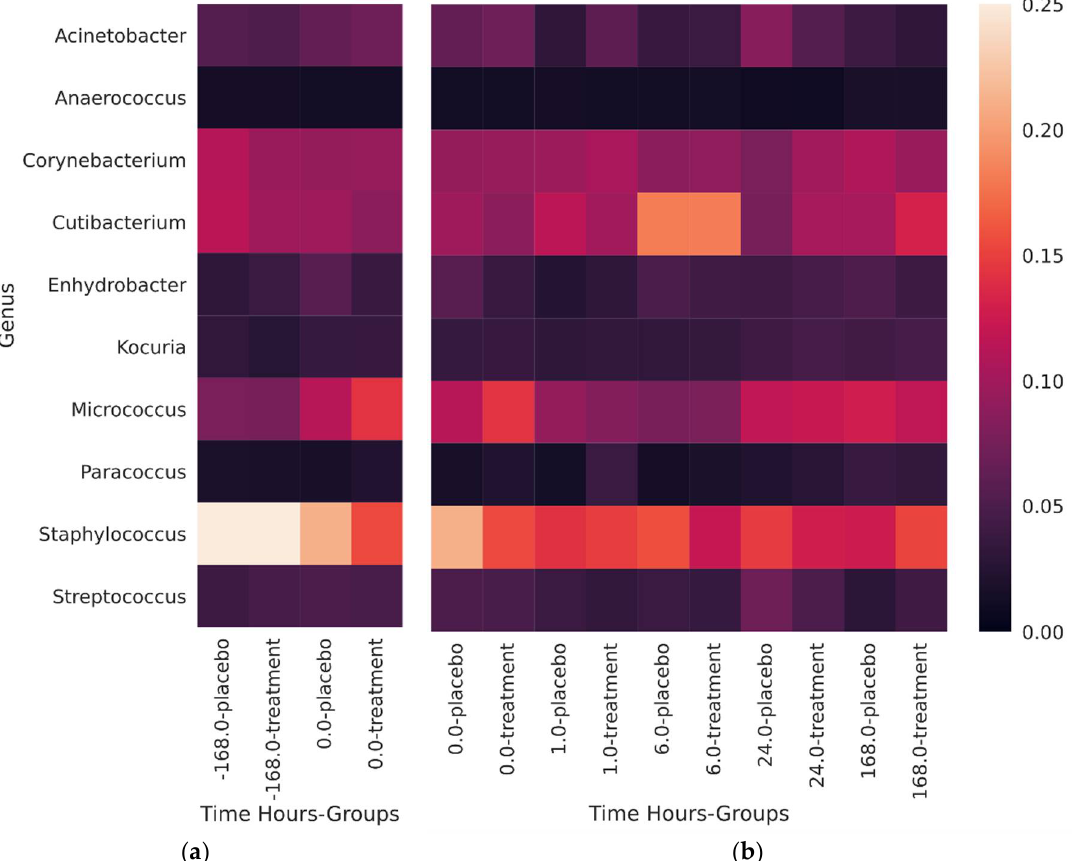
Figure 1. The 10 largest contributors to the relative abundance for ( a ) washout phase and ( b ) during the placebo / treatment phase. The 0 h timepoint is displayed in both ( a ) and ( b ) because it serves as a comparison for change in each of the trial